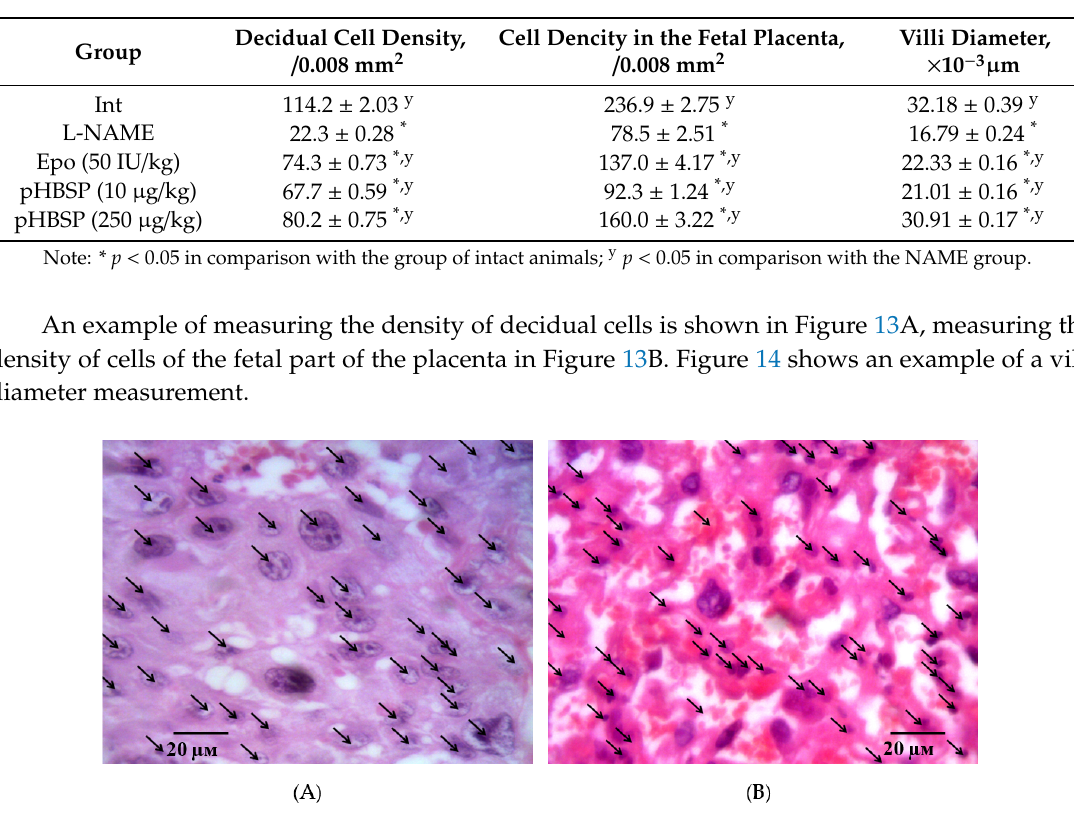
Figure 13. Measurement of the density of decidual cells ( A , indicated by arrow) and density of cells of the fetal part of placenta ( B , indicated by arrow) on the 21st day of gestation in animals with ADMA-like preeclampsia when pHBSP was administered at the dose of 250 µ g / kg. Note: Hematoxylin and eosin staining. Magnification: 400 ×